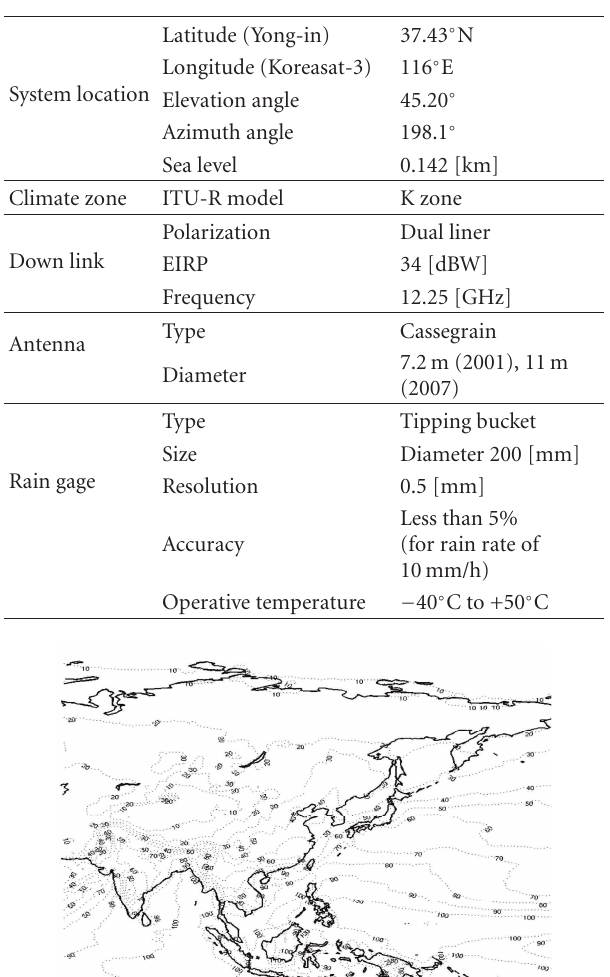
Table 1: Measurement and experimental specifications.